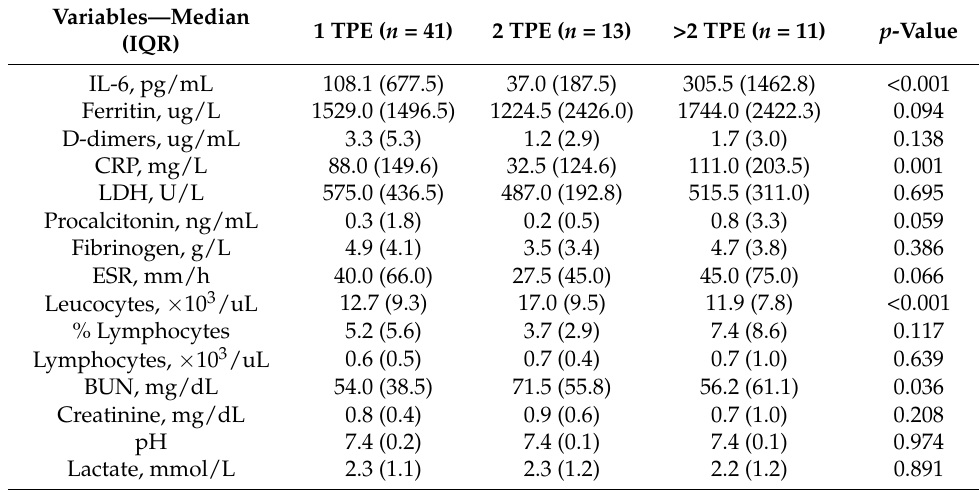
Table 2. Laboratory findings of patients with severe COVID-19 before